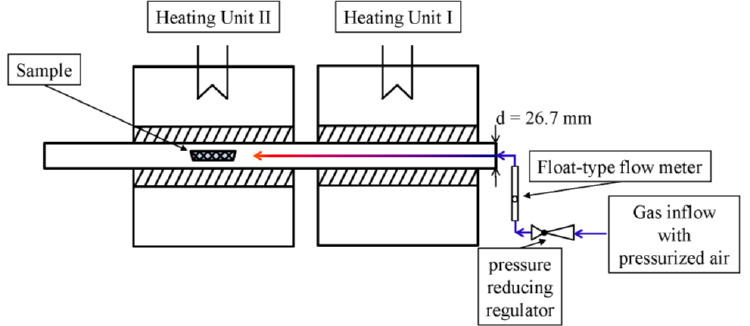
Figure 1. Principle drawing of the setup of the double-tube heating unit for convective and radiative heating.